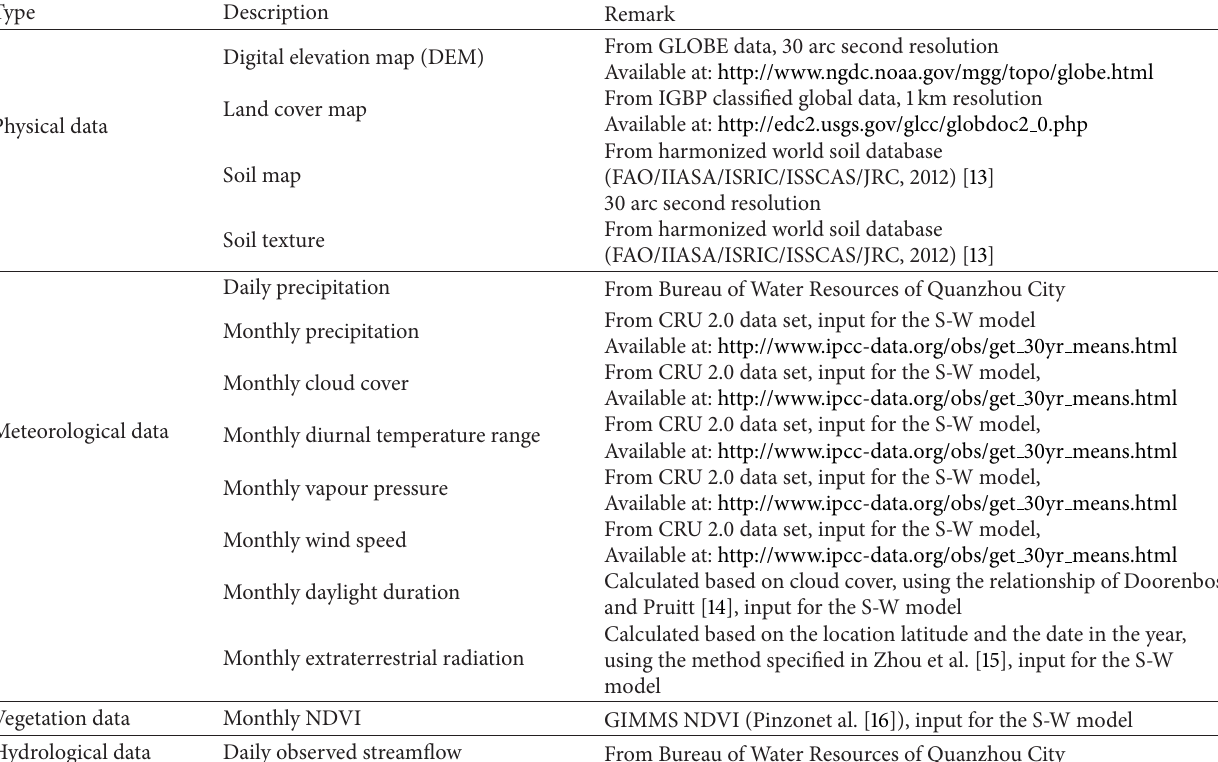
Table 1: Data used in BTOPMC modeling in Jinjiang